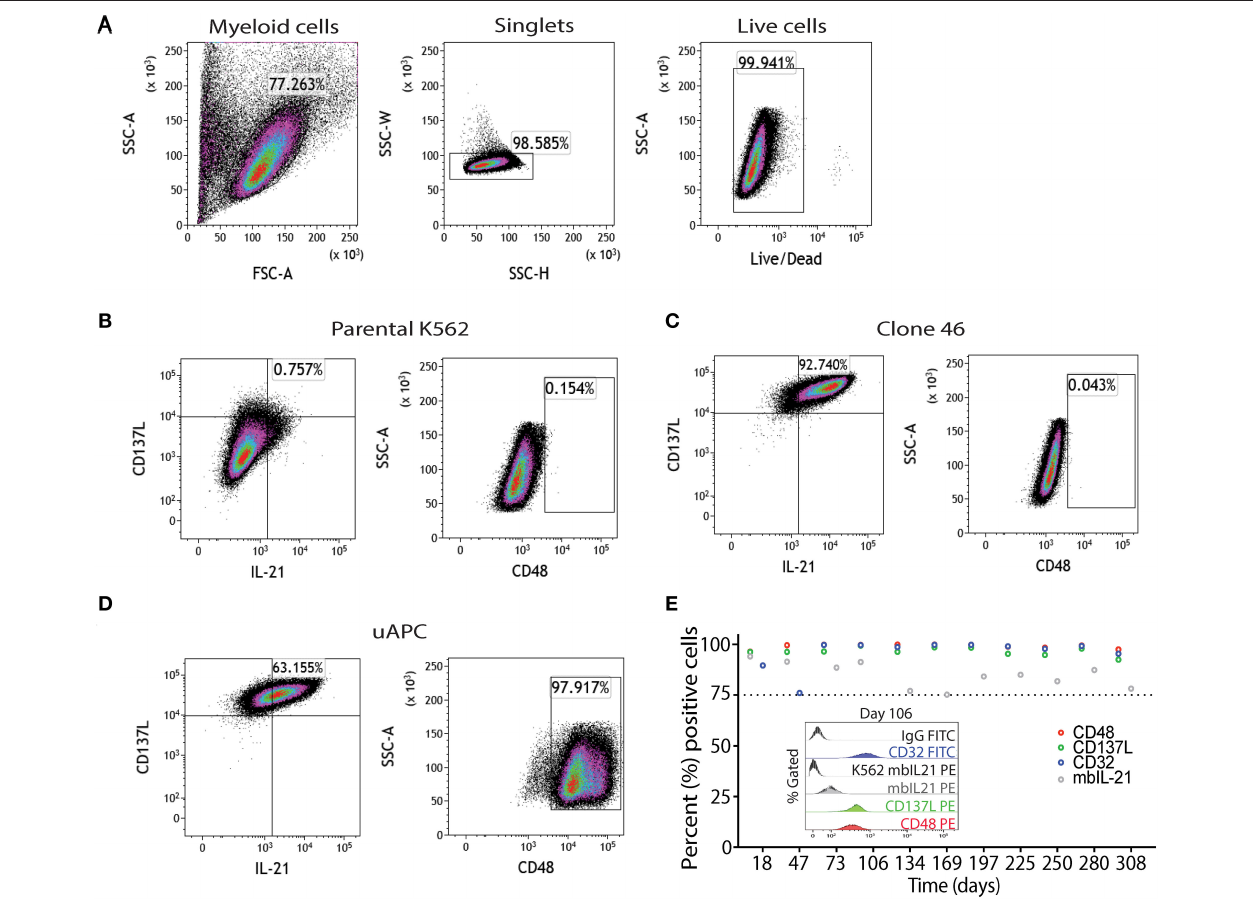
FIGURE 2 | Phenotypic characterization of uAPC. (A) Representative fluorescence-activated cell sorting (FACS) plots showing gating strategy to identify uAPC using FlowJo software (V10.5). Briefly, forward scatter and side scatter plot was used to gate on myeloid cells; next doublets were excluded using SSC-W/SSC-H and live cells were selected using Live/Dead dye. Representative FACS plots of the parental K562 cells ( B , negative for all transgenes), clone 46 ( C , IL-21 + CD137L + ), and uAPC ( D , IL-21 + CD137L + CD48 + Katushka + cells). (E) The expression levels of CD48 (red circles), CD137L (green circles), membrane-bound IL-21 (mbIL-21; gray circles) and CD32 (blue circles) were assessed periodically by flow cytometry from aliquots of continuously cultured uAPC to determine stability of integrated transgenes. Inset histogram depicts the expression of indicated markers at day